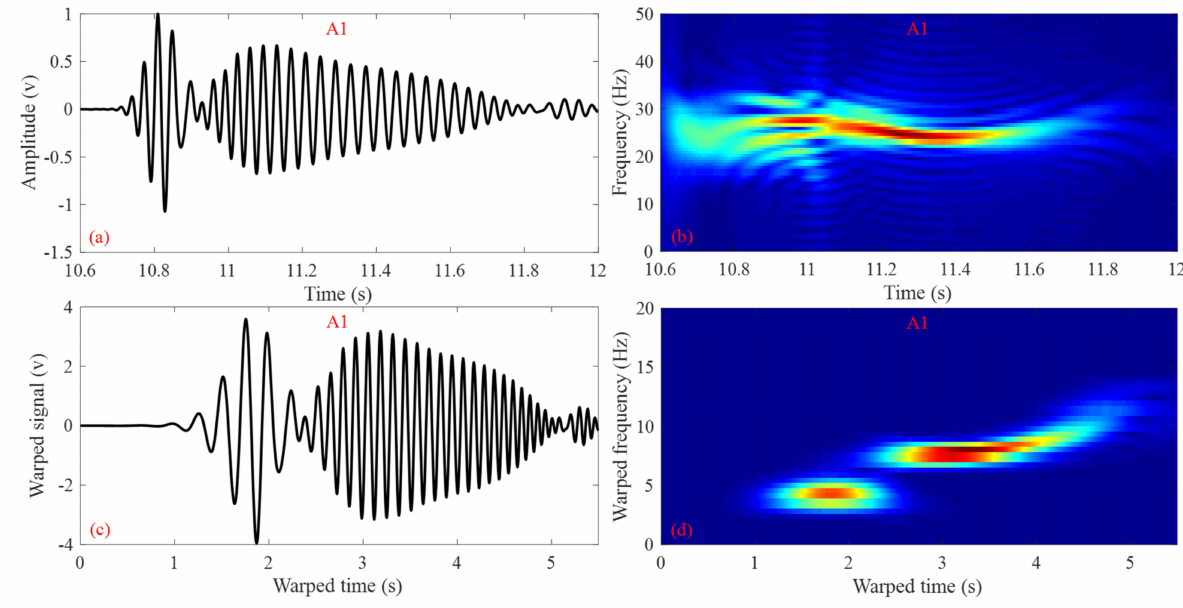
Figure 2. ( a ) The signal received by hydrophone A1 ( b ) the corresponding STFT, ( c ) the warped signal, and ( d ) the corresponding